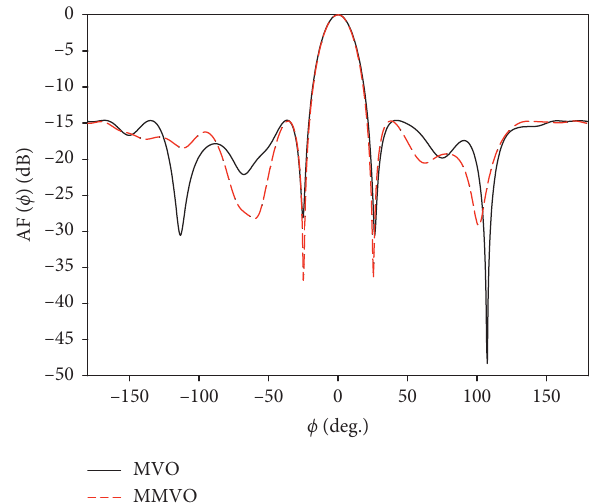
Figure 6: Radiation pattern of the optimized 12-element